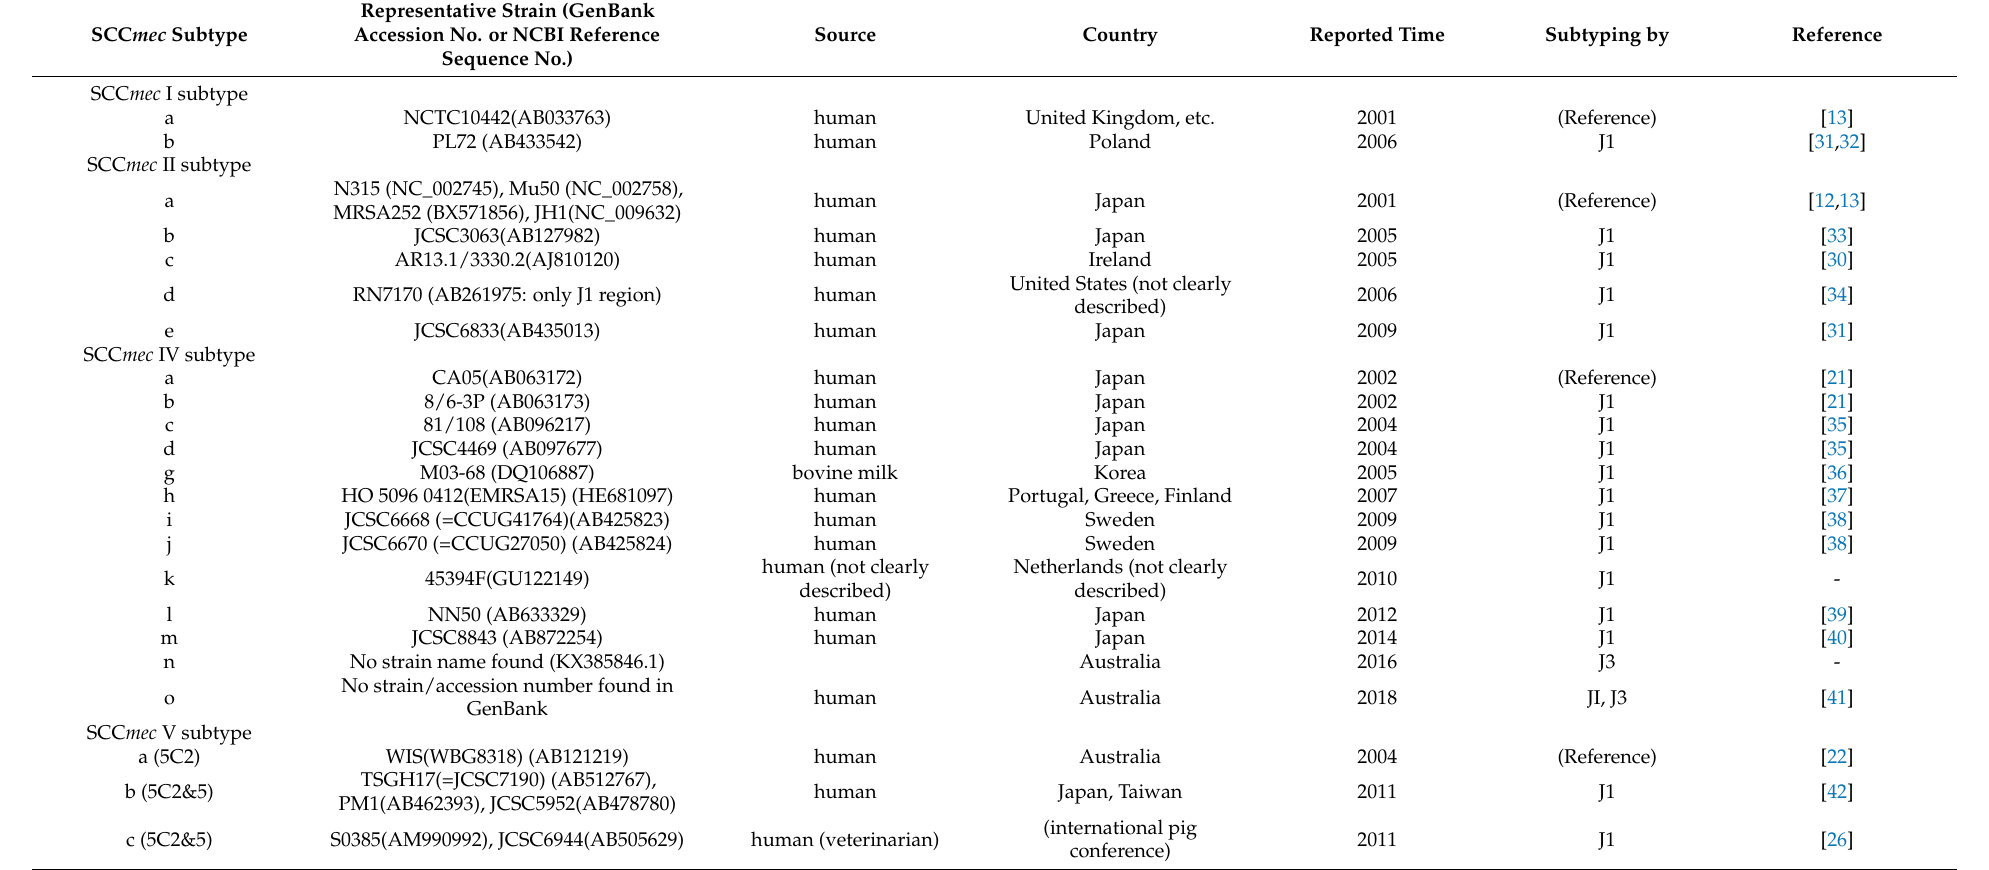
Table 3. Current SCC mec I, II, IV and V subtypes (14 December